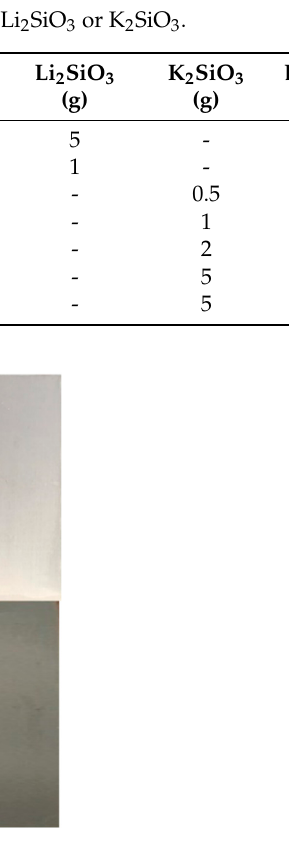
Figure 13. The morphology of sample with different coatings: ( a ) 1% Li-Ac, ( b ) 0.5% K, ( c ) 1% K, ( d )2% K, ( e ) 5% K-Mg and ( f ) 5% K-Mg after NSS for 72 h.